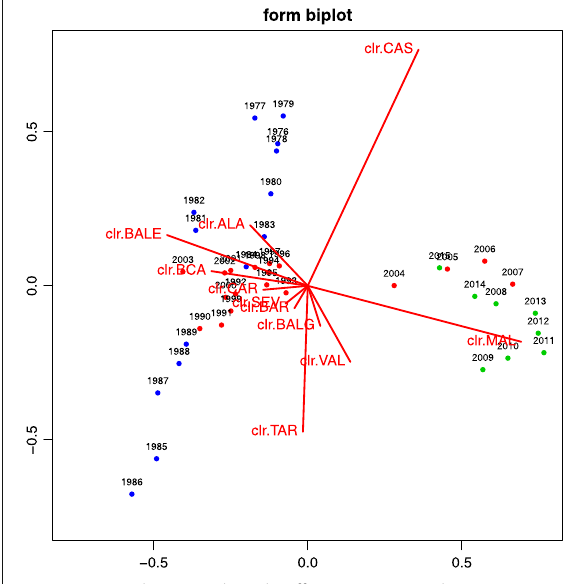
Fig. 7 Form Biplot. SpanishMed traffic composition. The projection represents more than 68% of variance. Blue dots correspond to the period 1976–1989 (before containerization boom), red dots correspond to the period 1990–2007 (before the crisis) and green dots correspond to the period 2008–2015